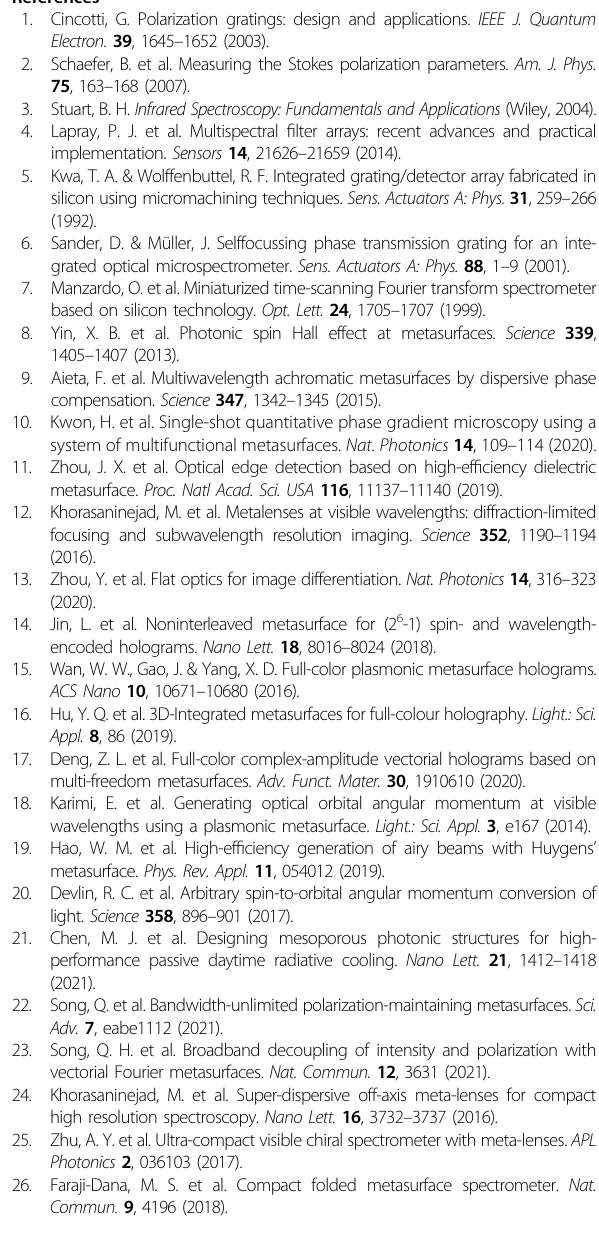
Measurement setup The experimental apparatus is composed of input light control part, sample alignment part, and imaging part. The blackbody serves as the broadband light source and a series of narrowband fi lters to generate illuminations at different frequencies. Linear polarizer and liquid